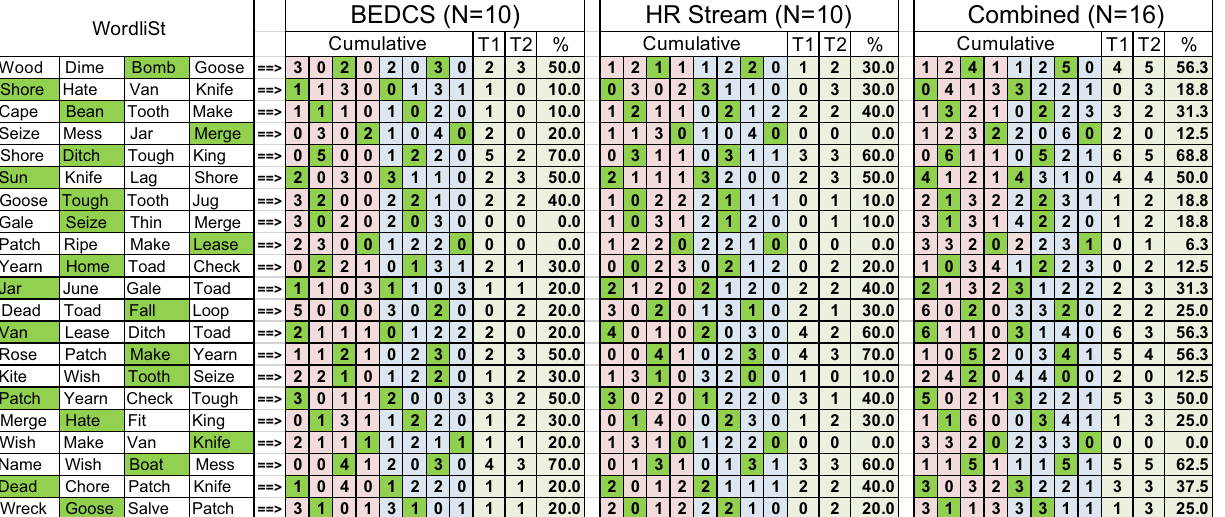
Performance above chance. As described in “Methods”, we corrected the threshold for chance for the small sample size using the MATLAB function binoinv(). For an N of 21 and a four-word forced-choice test, perfor- mance for each subject was above chance if the score was 42.5% or more. The performance differs among the test subjects (Fig. 3). None of the subjects tested with the BEDCS performed above chance during their first trial (trial 1) and only S6 during the second trial (trial 2). For the same word selected twice, S7 and S8 scored above chance. The scores were higher with the HR-Stream. S9b (retested S9) and S12 performed above chance during trial 1; S9b, S10, and S12 scored above chance during trial 2, and S9b through S12 for the same word selected twice. We tested the mean accuracy for all test subjects during trial 1, trial 2, and with a two-tailed binomial test (myBinomTest(); MATLAB_R2020b) if the number of questions answered correctly is above chance for trial 1, trial 2, and twice the same word (correct or wrong). Table 2 shows the results. The numbers are the probabilities to accept the hypothesis that the selection of the words during the forced-choice test is chance. The word recognition tasks’ performance was above chance for the combined data set if the probability shown was smaller than 0.05.